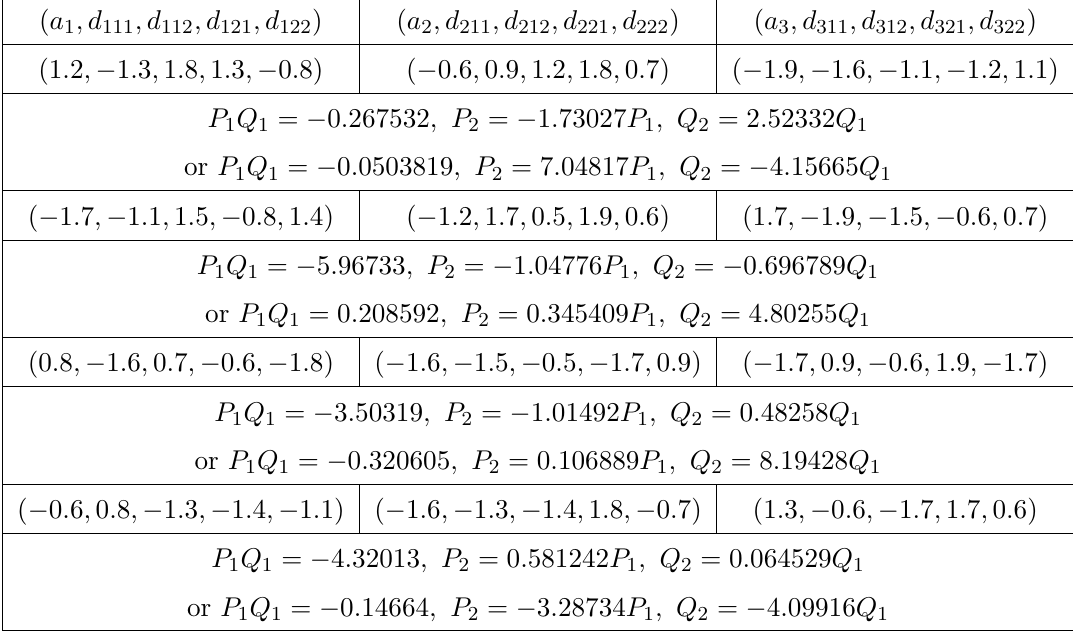
Table 1 . Numerical solutions to (4.14) with typical choices of coefficient